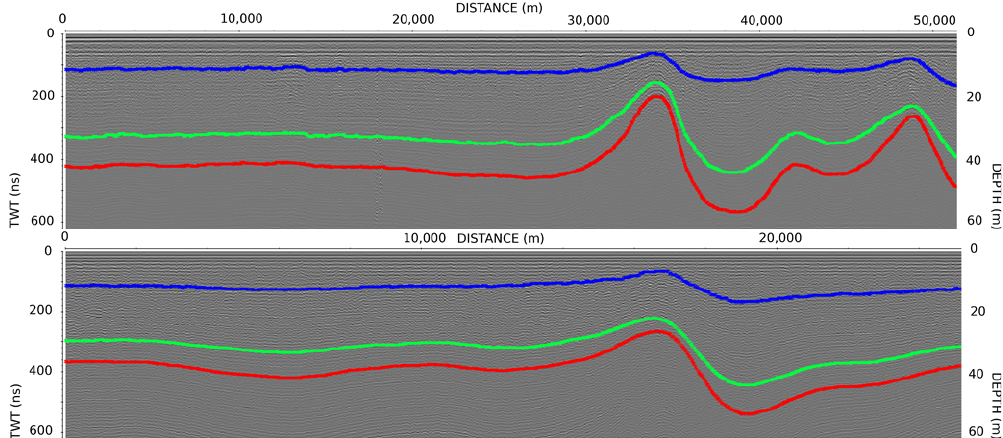
Fig. 7. Undulating structures visible on radargram 12 (4 February, 22:35UTC to 5 February, 02:09UTC, between 450 and 470km from DC) and radargram 14 (5 February, 04:41UTC to 06:39UTC, between 495 and 510km from